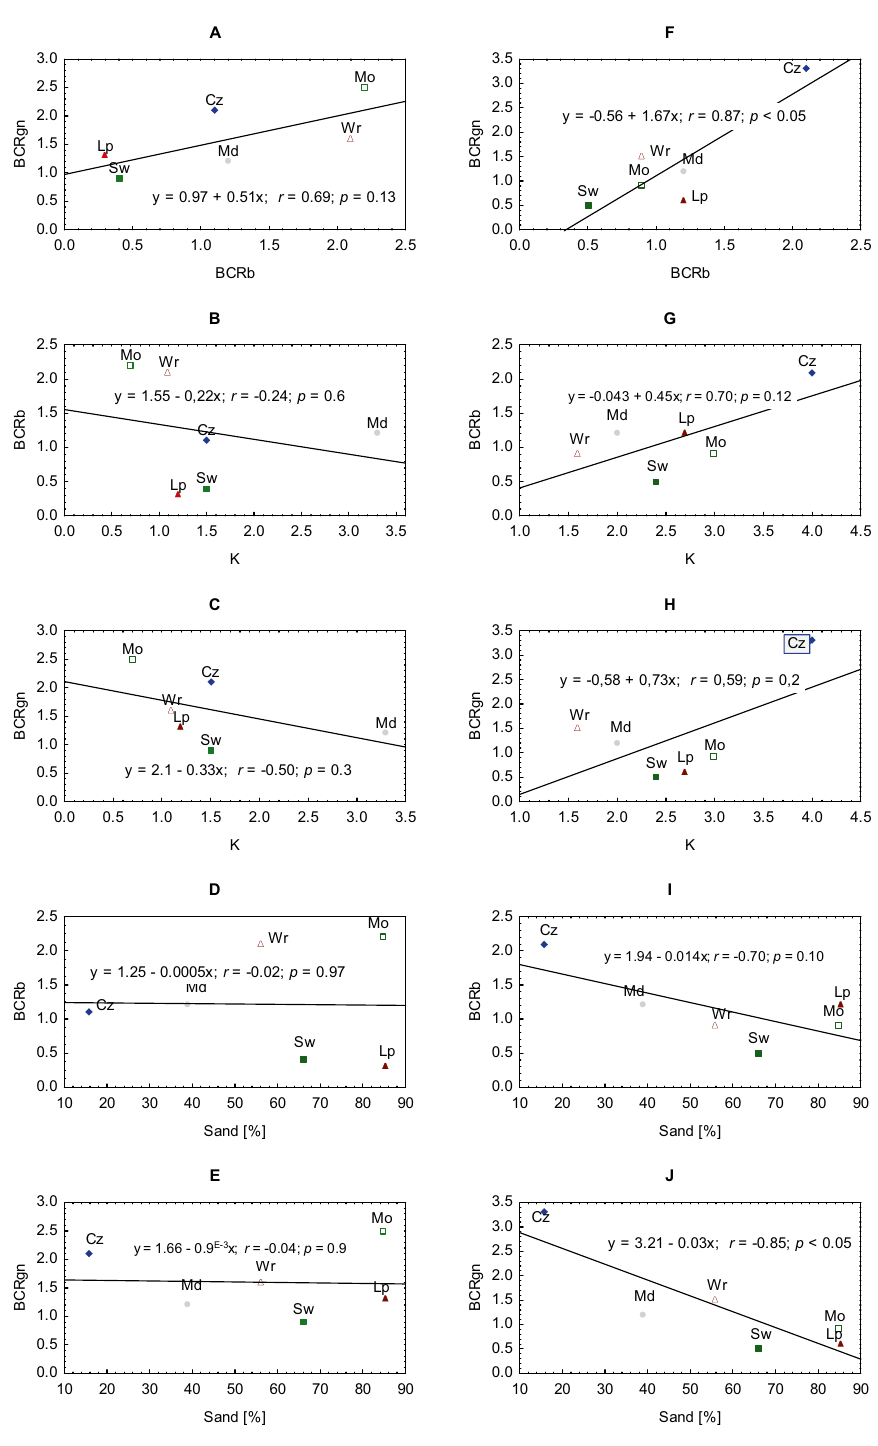
Figure 3. Correlation coefficients (r-Pearson) and linear regression of competitive ratio for biomass (BCRb) and grain numbers (BCRgn) between susceptible and herbicide-resistant blackgrass and between hydrothermal coefficient (K), sand content, and BCRb and BCRgn in two years of study ( A – E )—2018/2019, ( F – J )—